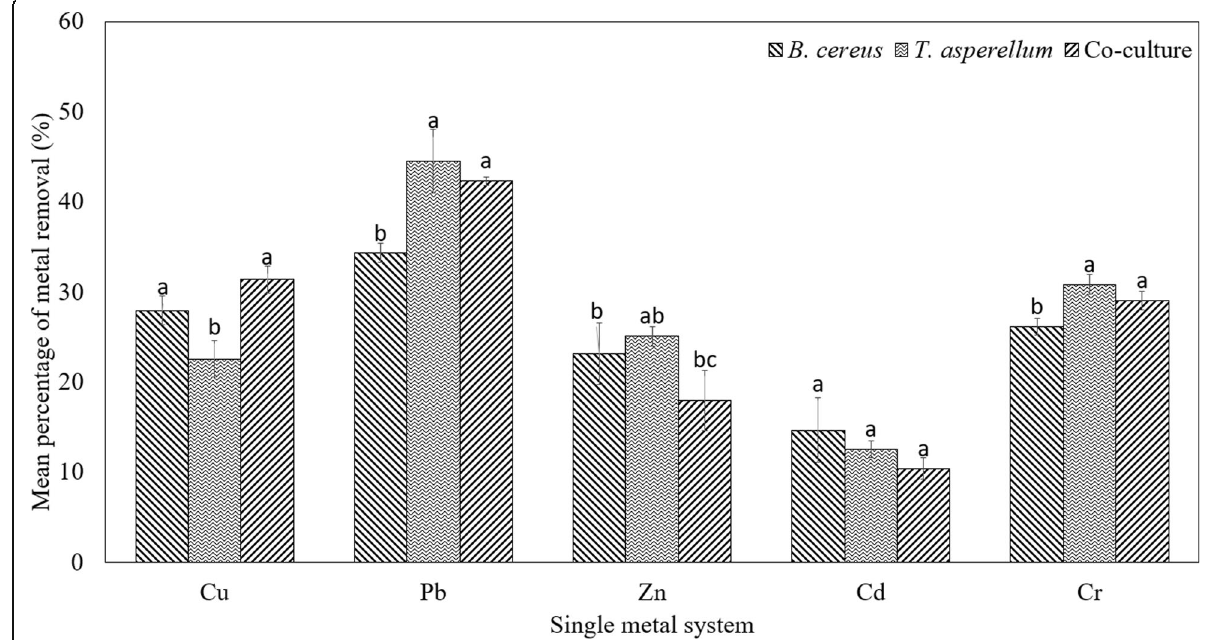
Fig. 5 Mean percentage (%) of metal (Cu, Pb, Zn, Cd, Cr) removal by EPS derived from single cultures of B. cereus , T. asperellum and from co- culture. Metal removal test was performed in single metal systems. Means with the same letters within the metal type indicate no significant difference according to Tukey comparisons (p < 0.05). Bars indicate standard deviation of